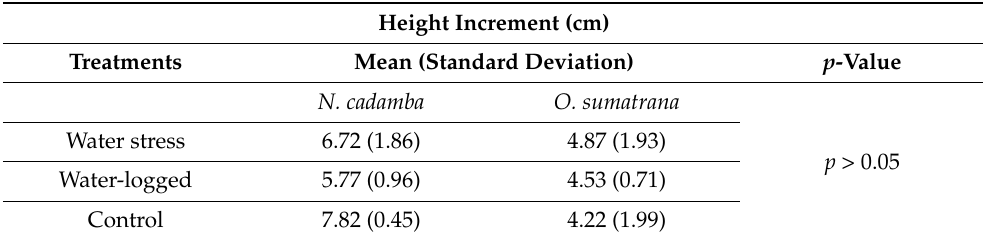
Table 2. Mean values of height increment (cm) of N. cadamba and O. sumatrana seedlings under different treatments ( n = 3) were not significantly different ( p > 0.05) using two-way ANOVA followed by Tukey’s HSD post hoc.